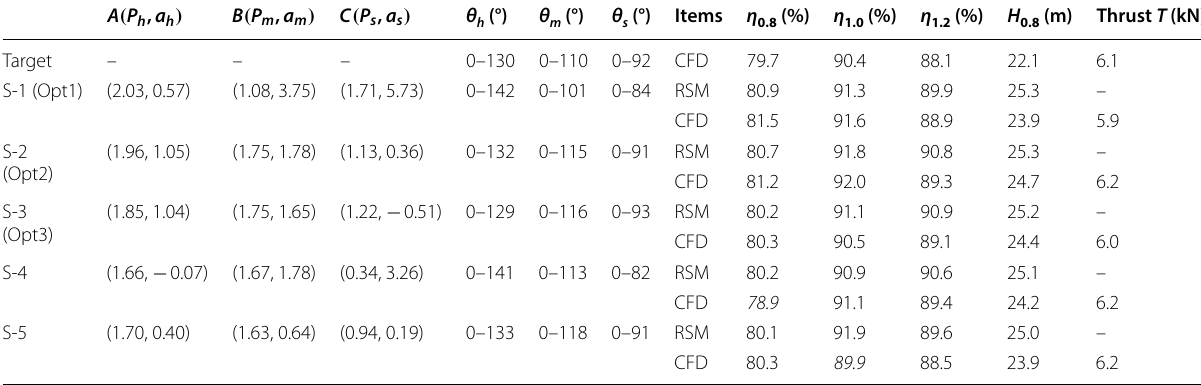
Italic values indicate the failure to meet the target performance A ( P h , a h ) Variables generating the hub angles; B ( P m , a m ) Variables generating the middle angles; C ( P s , a s ) Variables generating the shroud